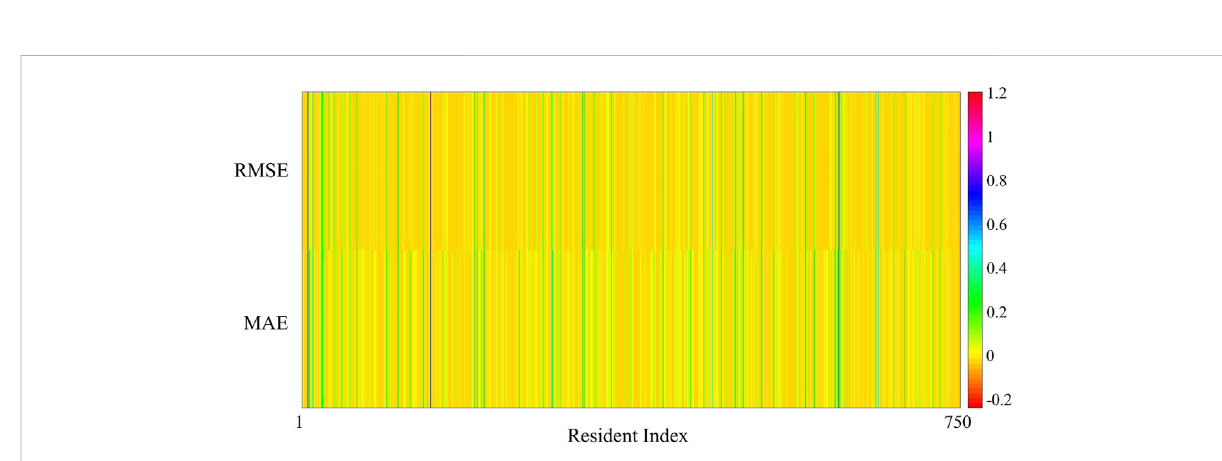
FIGURE 2 RMSE and MAE reduction of the proposed method compared to the benchmark